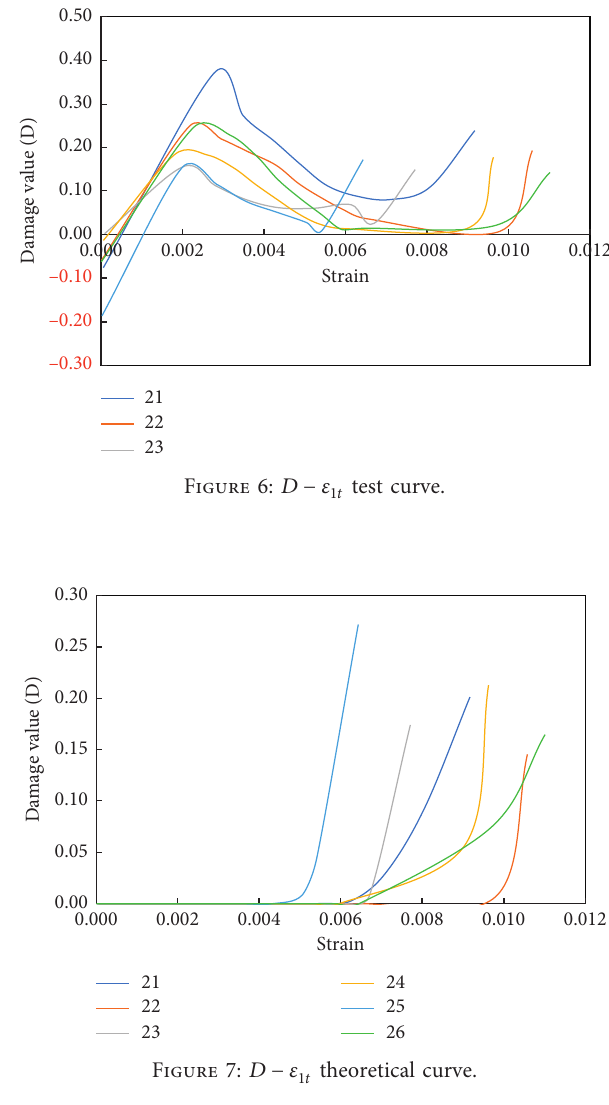
theoretical curve. 1 t